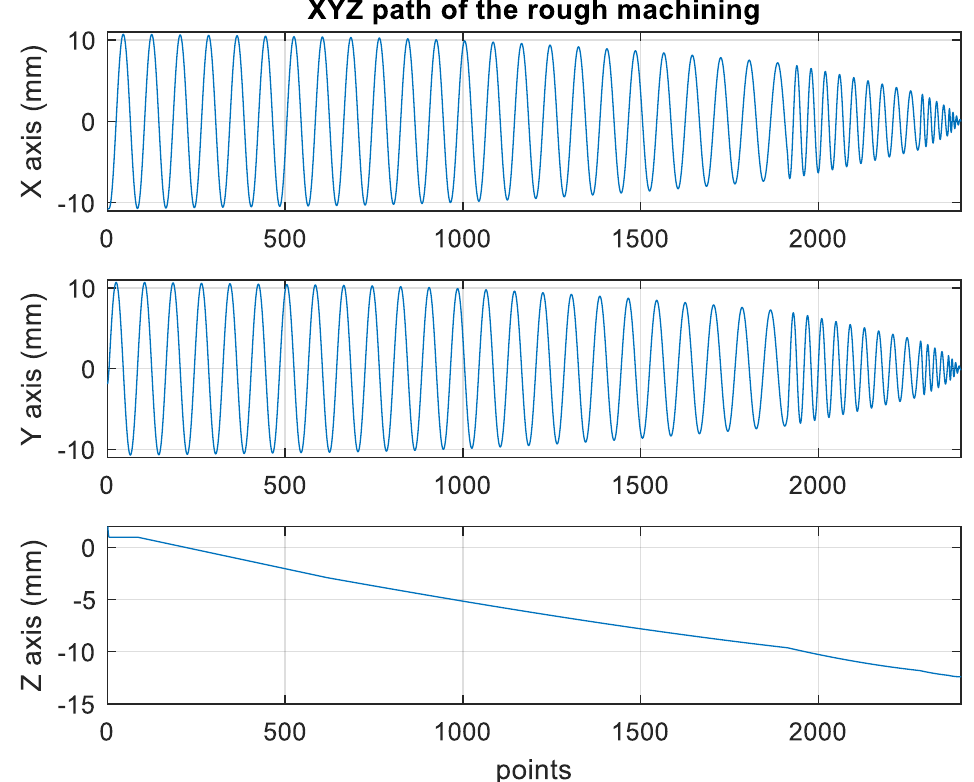
Figure 10. XYZ path of original rough machining program.